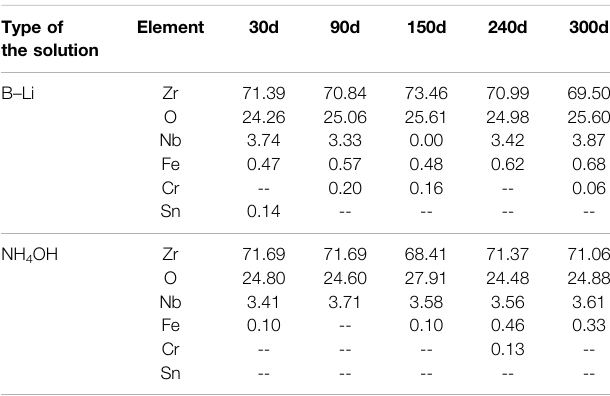
TABLE 4 | EDS results of the chemical compositions of the surface oxide fi lms (wt%). Type of the solution